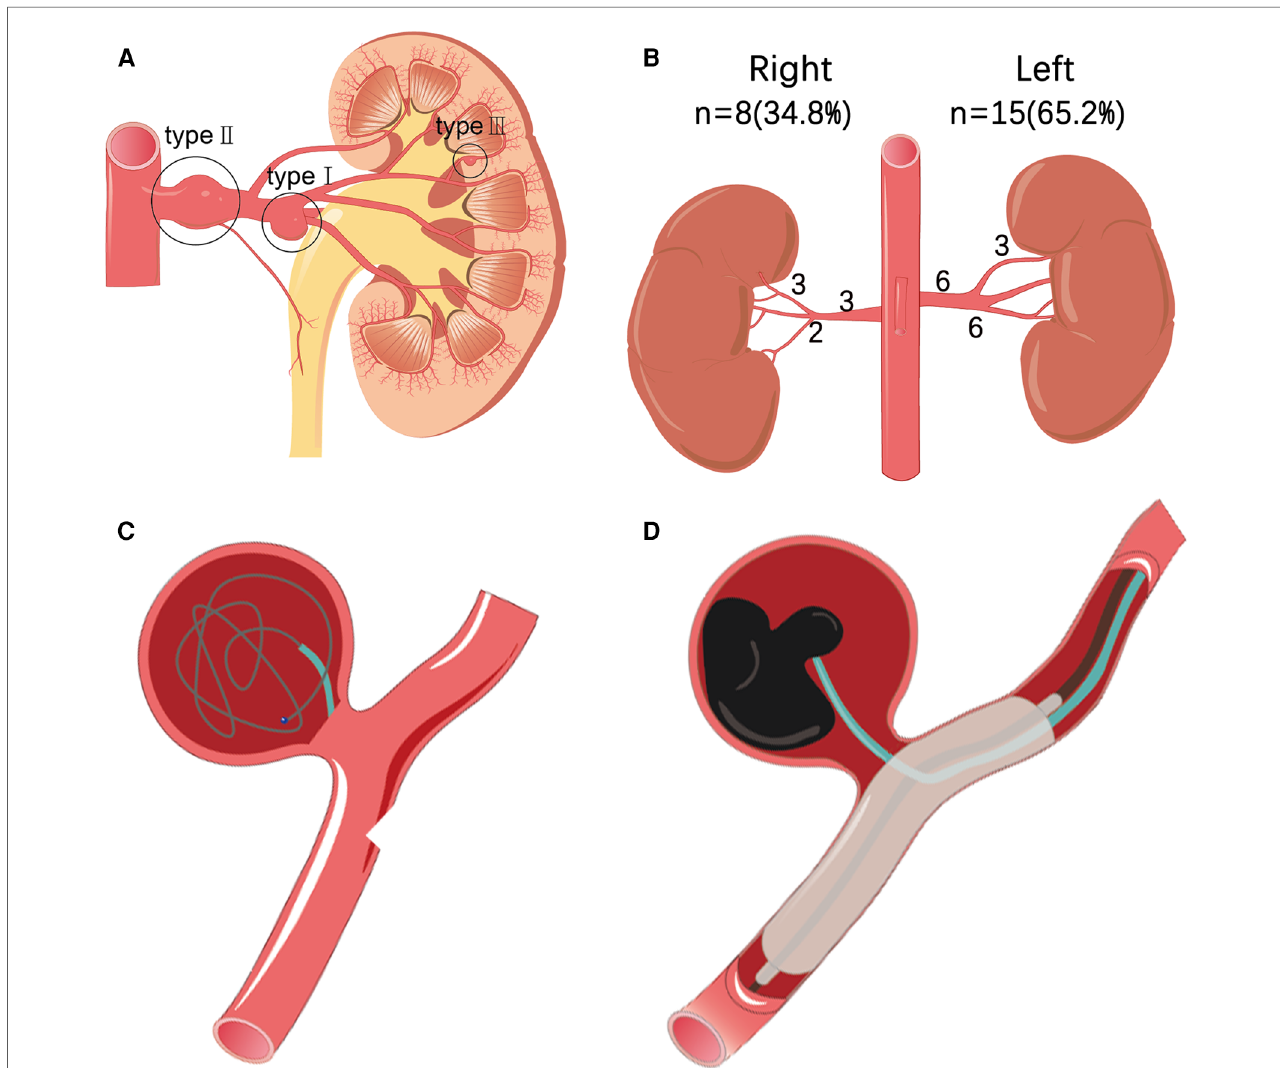
FIGURE 1 ( A ) According to the morphological classi fi cation of renal aneurysms: type I is located in the main or fi rst-level branch of the renal artery saccular aneurysm, type II is a fusiform renal aneurysm, and type III is an interlobular renal aneurysm. ( B ) Statistics of the location and distribution type of 23 cases of renal aneurysms. ( C ) Interventional treatment plan for renal aneurysms, such as schematic diagram of stent coil embolization. ( D ) Interventional treatment plan for renal aneurysms includes a schematic diagram of liquid glue